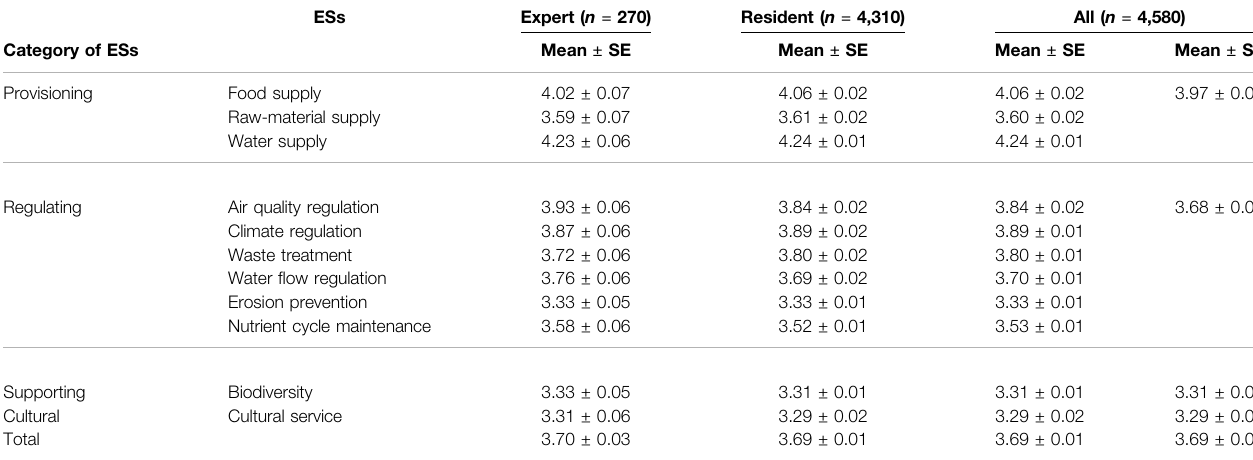
TABLE 1 | Perceived importance of ESs (average, with SE); SE: standard